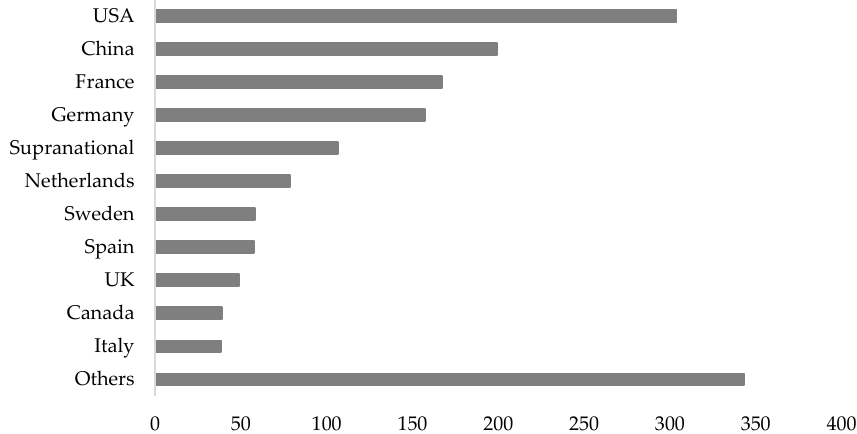
Figure 2. Green bond issued by country in 2021. Source: climatebonds.net, accessed on 3 January 2023.